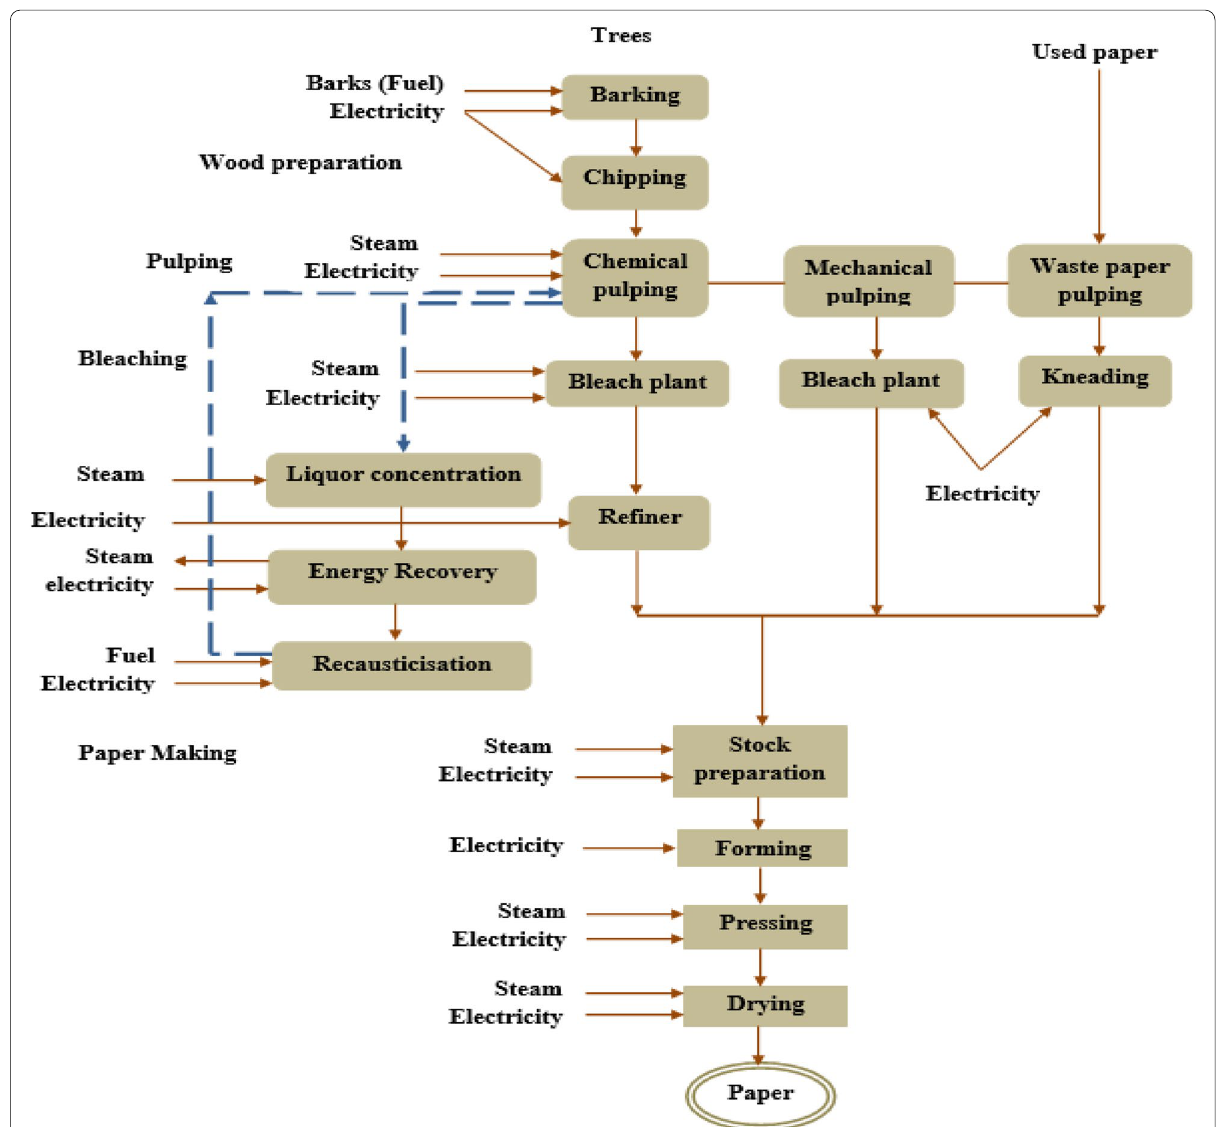
Fig. 3 Process flow in pulp and paper manufacturing